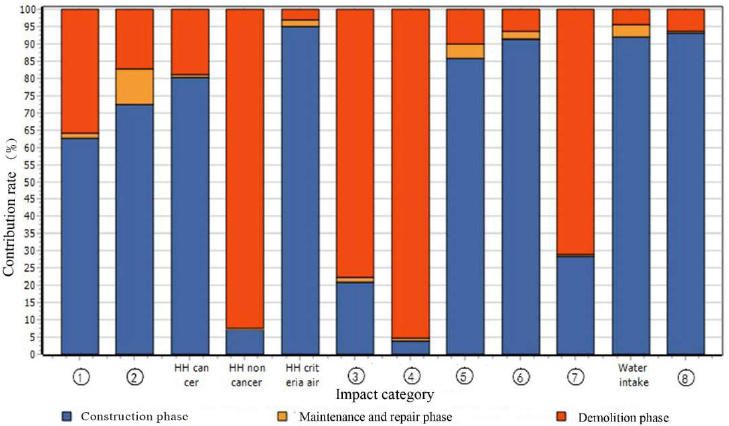
Figure 3. The characterization result of fast track transportation project in life cycle. Note: HH cancer, HH noncancer, HH criteria air pollutants, and Water intake are redundant Environmental impact categories which are currently used less frequently. This study does not take those four categories into account. The meanings of the 1 (cid:13) ~ 8 (cid:13) are: 1 (cid:13) Global warming, 2 (cid:13) Acidification, 3 (cid:13) Eutrophication, 4 (cid:13) Ecotoxicity, 5 (cid:13) Smog, 6 (cid:13) Natural resource depletion, 7 (cid:13) Habitat alteration, 8 (cid:13) Ozone depletion.